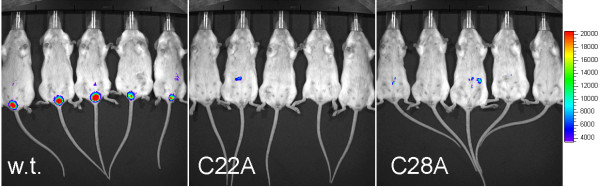
Impact of L2 C22A and C28A point mutations upon vaginal infection of mice by HPV16 pseudovirions. Mice (5/group) were treated with Depo-provera 4 days prior to challenge and then microtrauma was produced in the vaginal epithelium using a cytobrush [14]. The mice were then challenged intra-vaginally with equivalent doses, as determined by L1 concentration, of HPV16 pseudovirions containing a luciferase reporter plasmid and wild type L2 or single C22A or C28A point mutations, in a carboxymethylcellulose gel [2]. Three days post-challenge, luciferin was introduced into the vaginal vault and as a surrogate of infection the production of light by luciferase was visualized using a Xenogen IVIS 200 instrument.